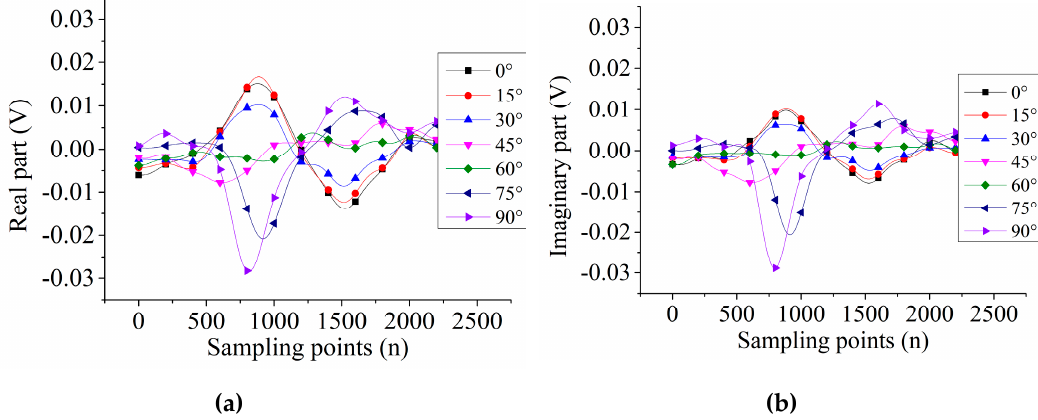
Figure 7. The signal output of 5-mm length defect by probe B: ( a ) real part, ( b ) imaginary part.